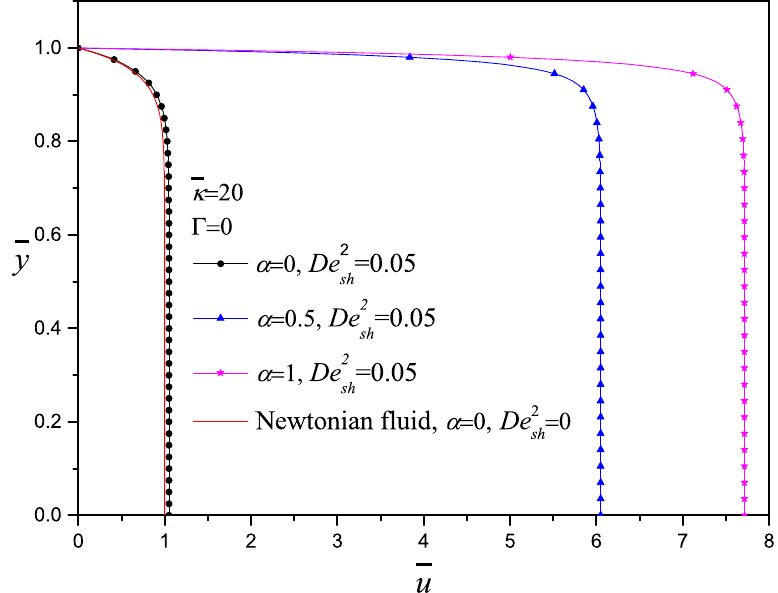
Figure 4. Effect of the codeformational ( α = 0 ) , mixture ( α = 0.5 ) and corotational ( α = 1 ) derivatives on the velocity profile with κ = 20, Γ = 0, De 2